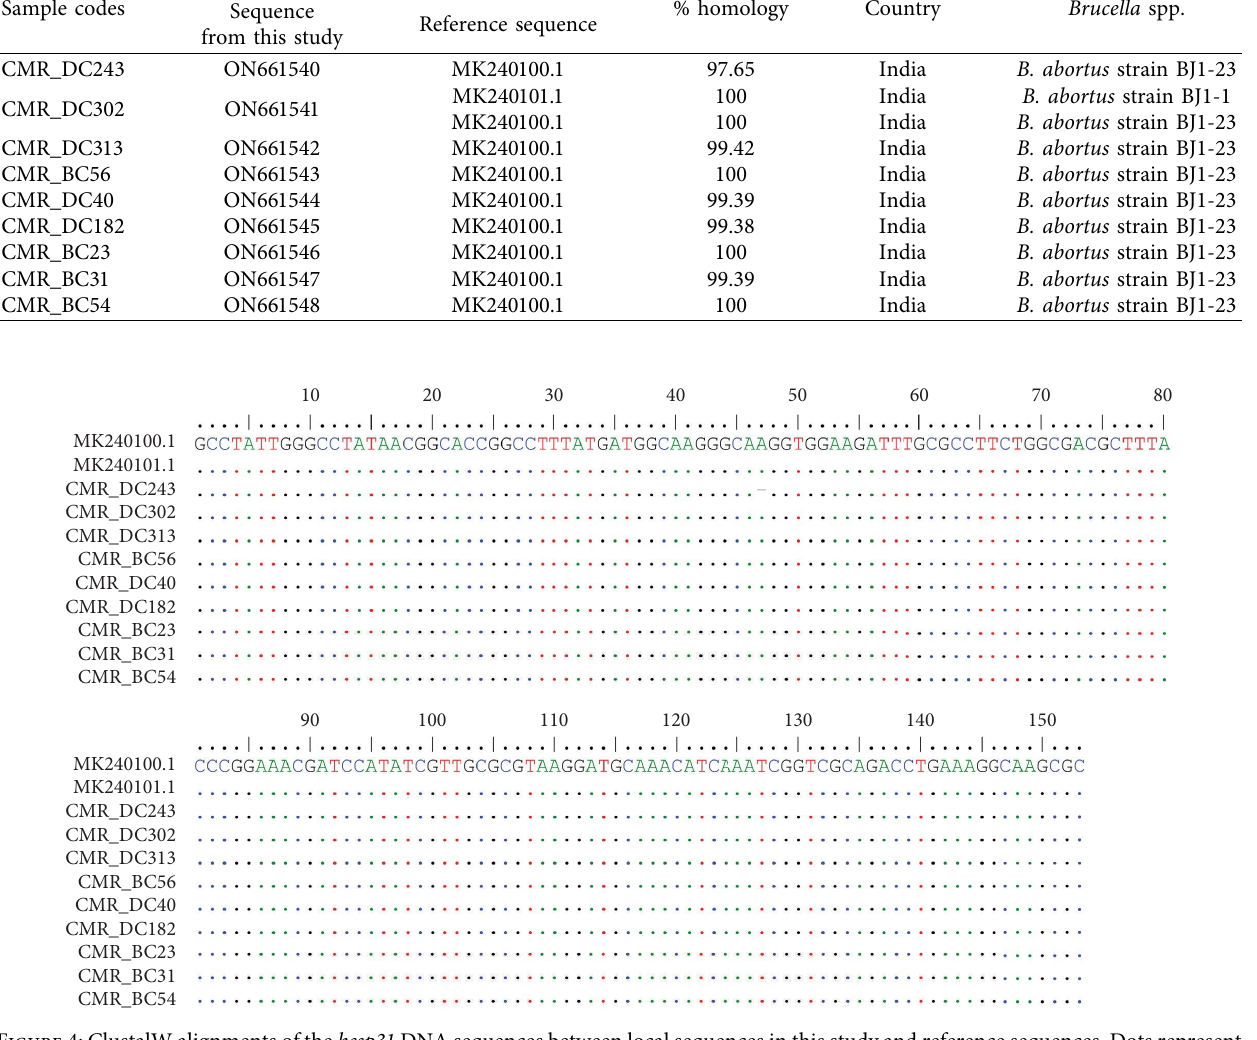
Table 6: Percent homology between the 31kDa antigen ( bcsp31 ) gene sequences of local Brucella spp. identifed in this study and the reference sequences from GenBank. Sample codes